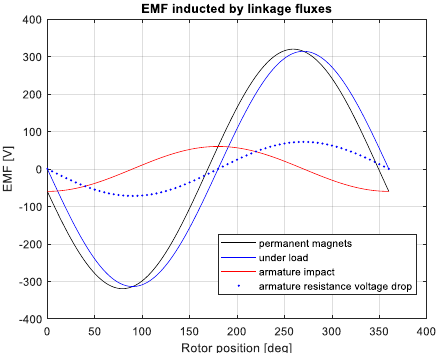
Figure 9. First harmonics of EMF induced by linkage fluxes in the proposed flat core design.